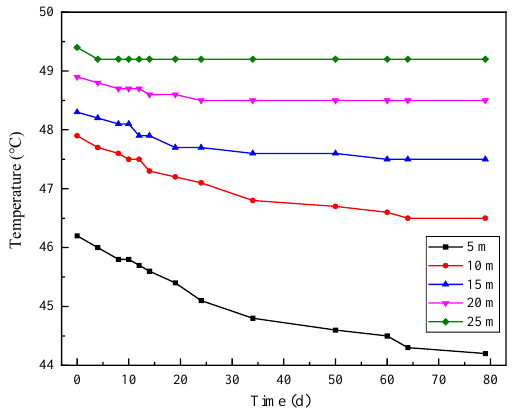
Figure 4. Results of temperature field tests on the surrounding rock.